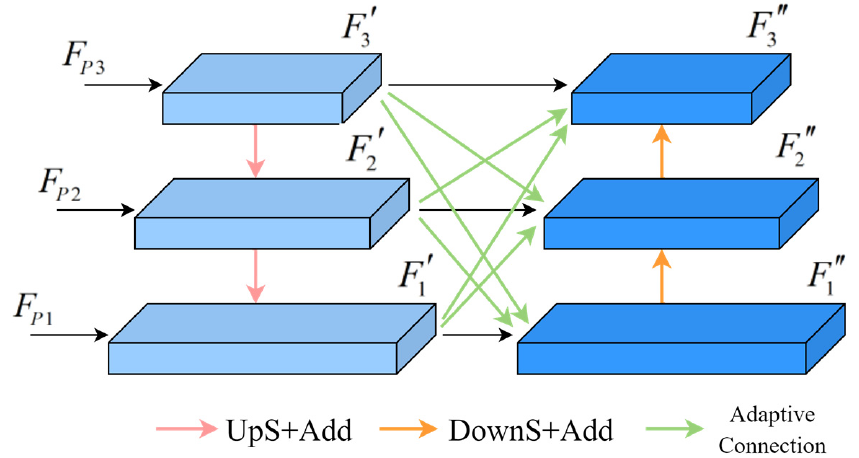
Figure 3. Adaptive feature-aware module structure.